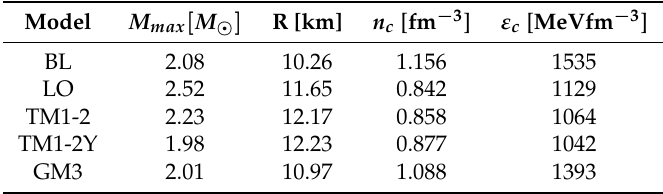
Table 1. Maximum mass configuration properties for the EOS models (first column) considered in this work. In the other columns are reported, respectively: the stellar gravitational maximum mass M max , the corresponding radius R , the central baryon number density n c and the central energy density (cid:101) c . Stellar masses are given in units of the solar mass: M (cid:12) = 1.989 × 10 33 g. Model M max [ M (cid:12) ] R [km] n c [ fm − 3